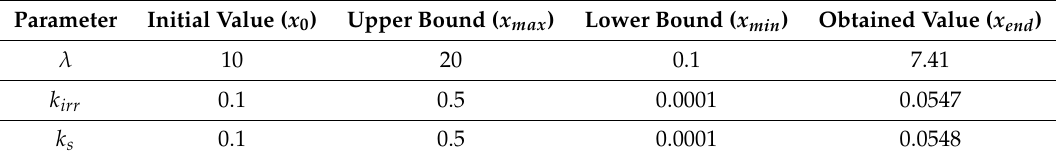
Table 2. Minimisation